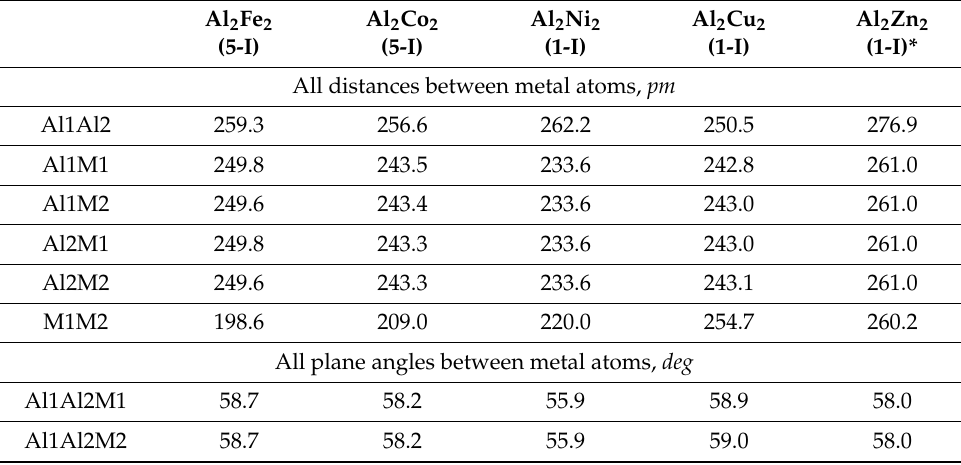
Table 3. Structural parameters of most stable Al 2 M 2 metal clusters (M = Fe, Co, Ni, Cu,